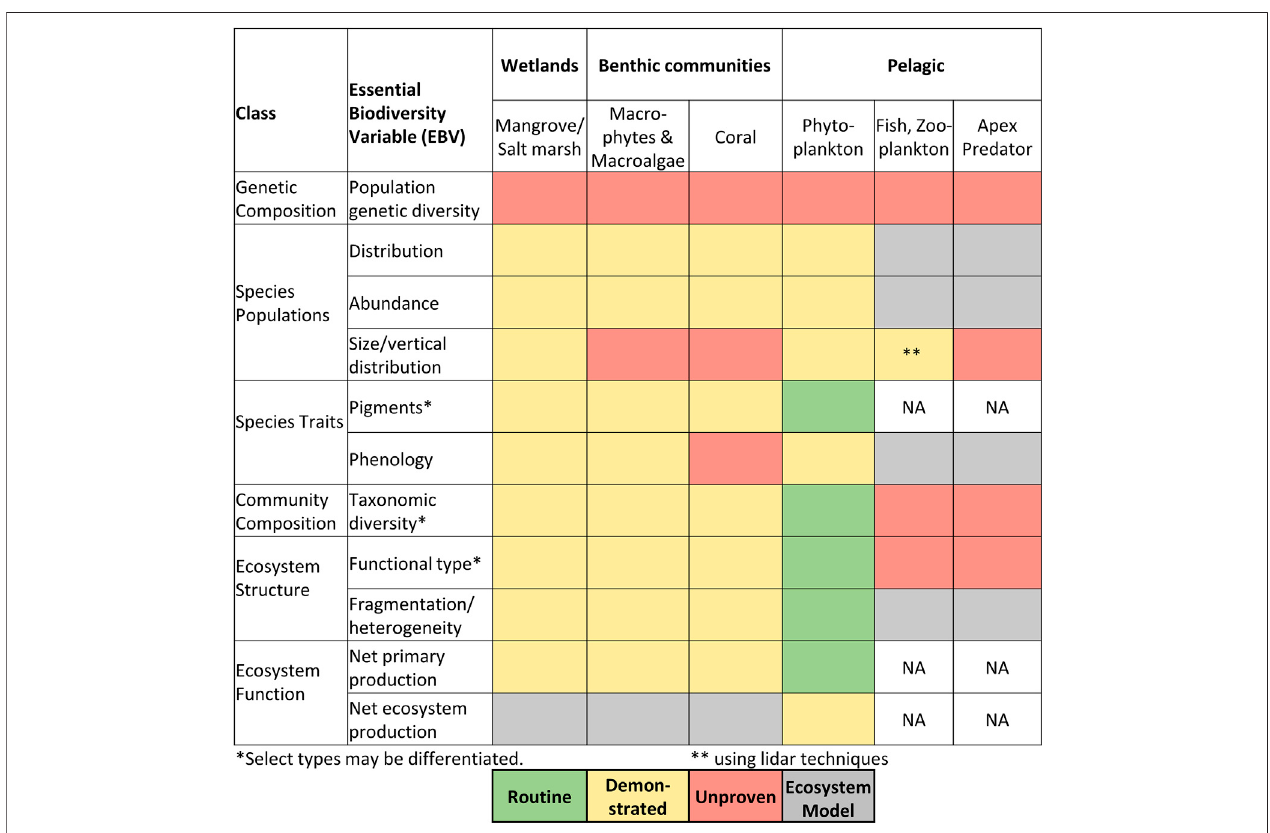
FIGURE 6 | Current capabilitiesofremotelysenseddatafor measuringEssentialBiodiversityVariables modi fi edfromMuller-Kargeretal. (2018). “ Unproven ” indicates that methods have not yet been developed to collect these measurements from remote sensing imagery. “ Demonstrated ” are methods that have been demonstrated and could potentially be produced with hyperspectral imagery. “ Routine ” indicates measurements that are produced regularly. “ Ecosystem model ” indicates EBVs that can be predicted on the basis of ecosystem models that may incorporate remote sensing imagery. “ NA ” indicates that the observation is not applicable.